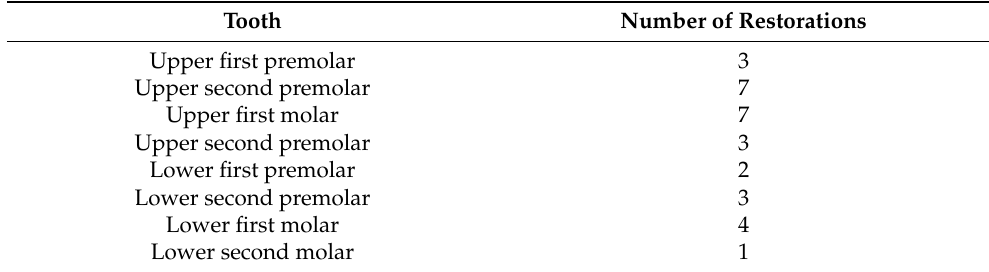
Table 1. Distribution of restorations.